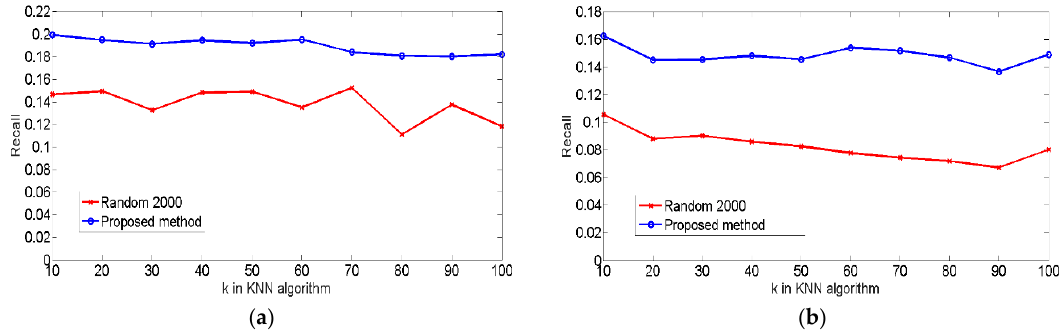
Figure 5. ( a ) Recall criterion with similarity measures of cosine; ( b ) Recall criterion with similarity measures of NHSM.